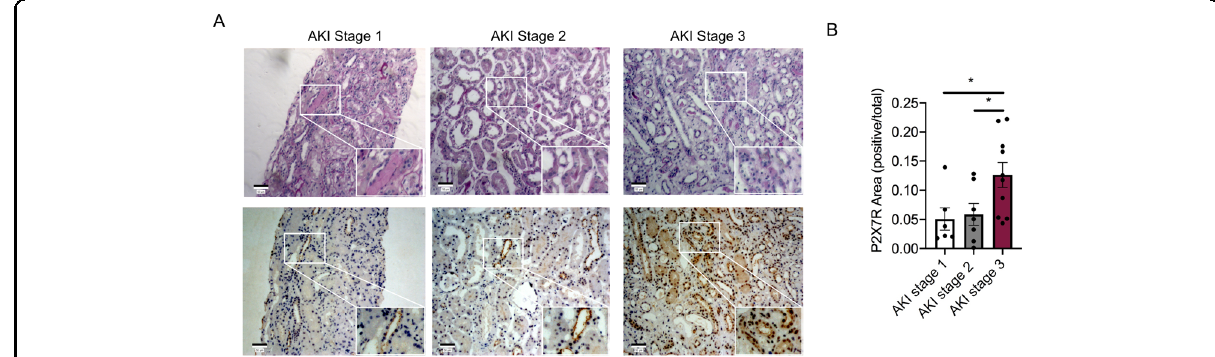
Fig. 5 The renal expression of P2X7 receptor was increased in patients with AKI stages 3. A PAS staining (top) and representative immunochemistry for P2X7 receptor (bottom) in human kidneys. B The positive areas for P2X7 receptor were calculated by a researcher who was blinded to the present study using Image-Pro Plus software. * p <